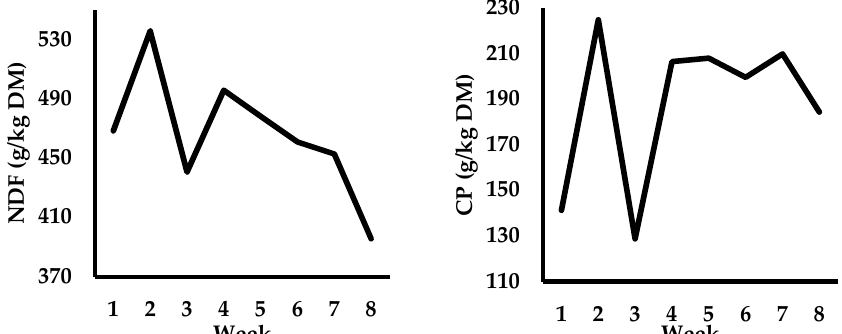
Figure 2. Changes in autumn herbage quality offered to dairy cows during the experiment (week 1 = September 9 and week 8 = October 28). A nitrogen partitioning study was conducted during week 2. Standard deviations across the 8-week experimental period were: ± 6.5 g ash/kg DM; ± 15.4 g DM/kg of FW (fresh weight); ± 10.0 g ADF/kg DM; ± 33.2 g WSC/kg DM; ± 38.3 g NDF/kg DM; and ± 32.5 g CP (crude protein)/kg DM.